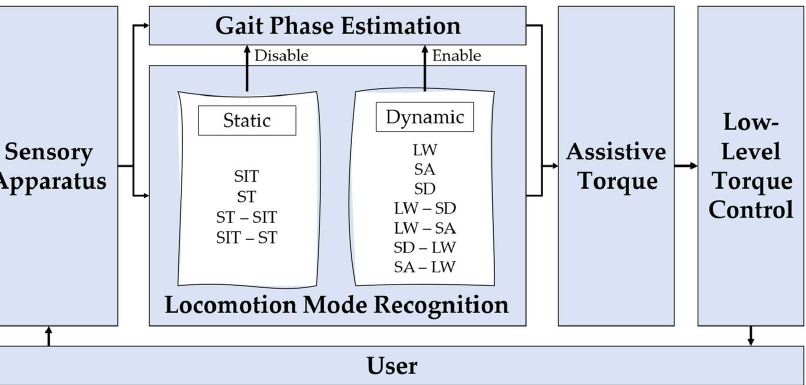
Figure 4. Control scheme adopted in [7]. For continuous dynamic tasks, the gait phase estimation algorithm was performed after the LM decoding and before the provision of assistive torque. Adapted from [7].